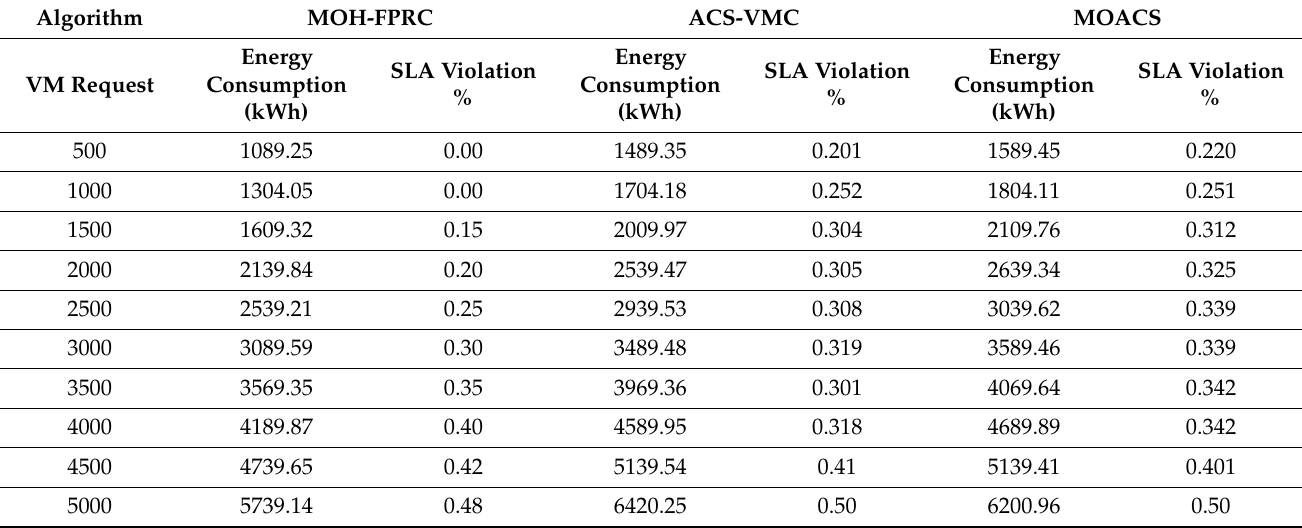
Table 2. Average energy consumption and SLA violation with different VM